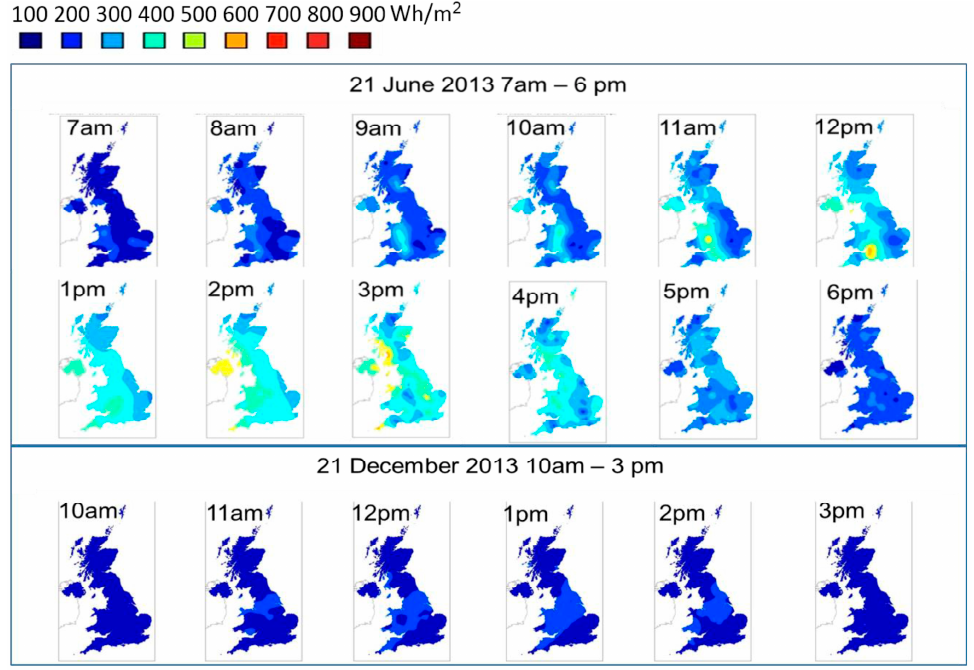
Figure 3. Kriged hourly global horizontal irradiation (bands of 100 Wh/ m 2 ) of two sample days (21 June 2013 and 21 December 2013).